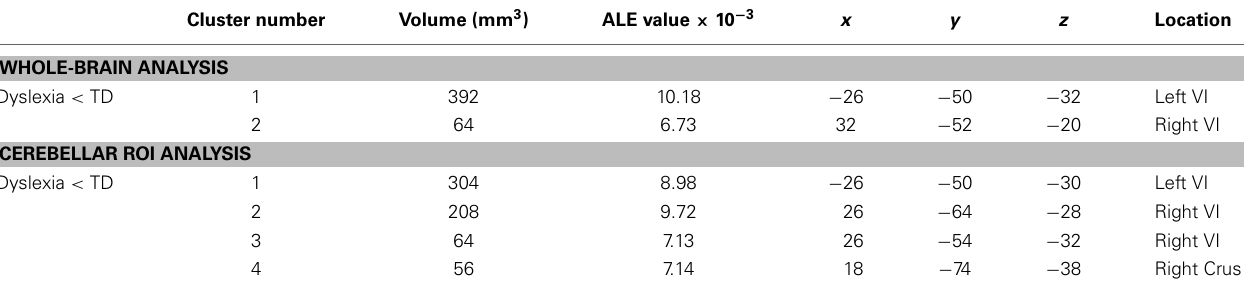
Table 5 | GM differences in dyslexia: whole brain and cerebellar-only analyses.